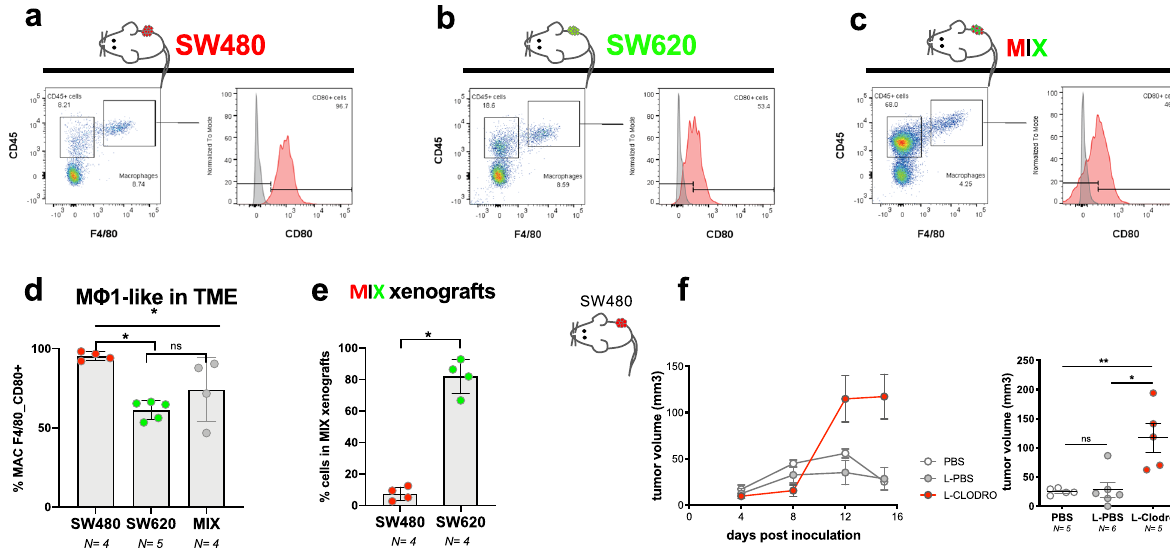
Fig. 6 Mice xenografts display similar TME behavior as zebra fi sh. a – c Representative graphs of fl ow cytometry analysis of the TME of SW480, SW620, and MIX mouse ( Rag1 − / − C57BL/6J) xenografts at 3 weeks post inoculation. d Quanti fi cation of double positive F4/80, CD80 macrophage in each TME, SW620 vs SW480. * P = 0.016, Cohen ’ s D g = 6.2; SW620 vs MIX ns = 0.29, Cohen ’ s D g = 0.83; SW480 vs MIX * P = 0.029, Cohen ’ s D g = 1.28). e Quanti fi cation of the percentage of each clone in MIX mice xenografts, * P = 0.029, Cohen ’ s D g = 7.68. d , e Data from quanti fi cation of fl ow cytometry analysis. Error bars represent mean ± S.D. f Growth curves of SW480 tumors treated with PBS, L-PBS, or L-Clodronate mice ( f ns = 0.43, Cohen ’ s D g = 0.12, ** P = 0.007, Cohen ’ s D g = 2.16, * P = 0.017, Cohen ’ s D g = 1.92). Error bars represent mean ± SEM. All data were analyzed using unpaired two-sided Mann – Whitney test. To avoid macrophage repopulation, mice were injected every 4 days (see “ Methods ” ). N is depicted in the chart. Each dot represents one mouse xenograft. Source data are provided as a Source data fi